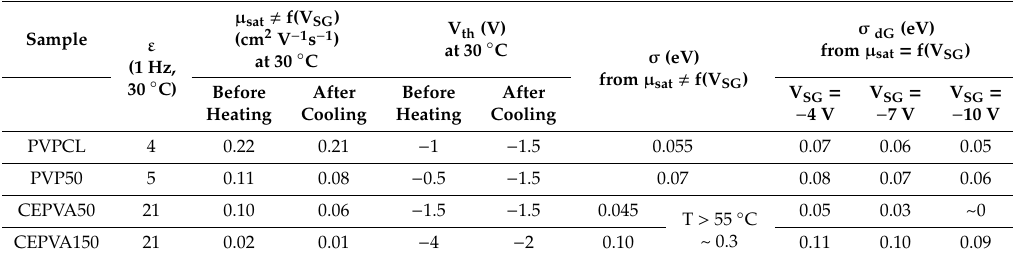
Table 1. Comparison of charge carrier mobility, µ sat , threshold voltage, V th , and local energy disorder, σ , of the gate voltage dependent, µ sat = f(V µ sat (cid:44) f(V SG ), and gate voltage independent mobility, SG ), for investigated OFETs with di ff erent dielectric layers prepared under di ff erent drying